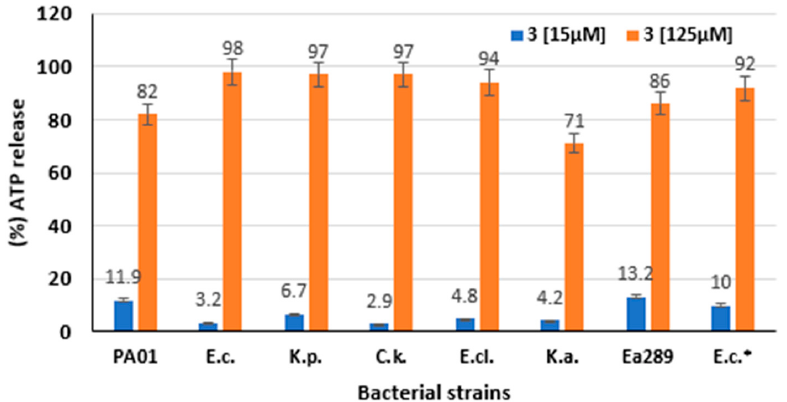
Figure 4. ATP release levels measurement in the presence of compound 3 . ATP release levels of various Gram ‐ negative bacteria (PA01, E. coli ATCC 25922, K. pneumoniae ATCC 13883, C. koseri IP8294, E. cloacae DSM 129, K. aerogenes ATCC 13048, K. aerogenes 289 (MDR), and E. coli AG100A_pUC18) evaluated after 1 minute by bioluminescence in the presence of compound 3 at 15 µ M and 125 µ M. In each case, polymyxin B (250 µ M) was used as a positive control to quantify the maximum level of ATP efflux. * Refers to E. coli